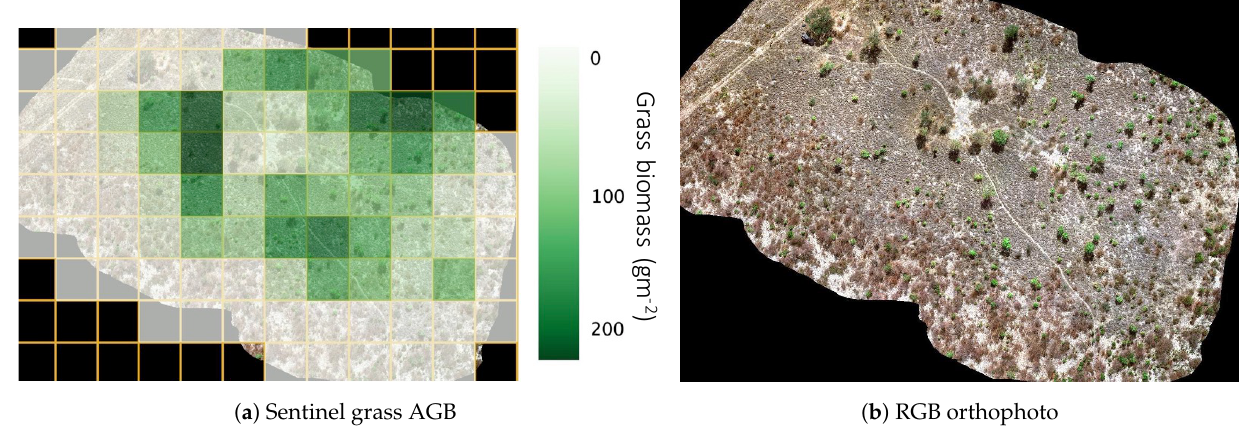
Figure 12. Example of ( a ) the grass AGB model applied to Sentinel-2 pixels in a plot in Tsodilo and ( b ) and RGB image of the plot for reference. Each box in the yellow grid in ( a ) corresponds to a Sentinel-2